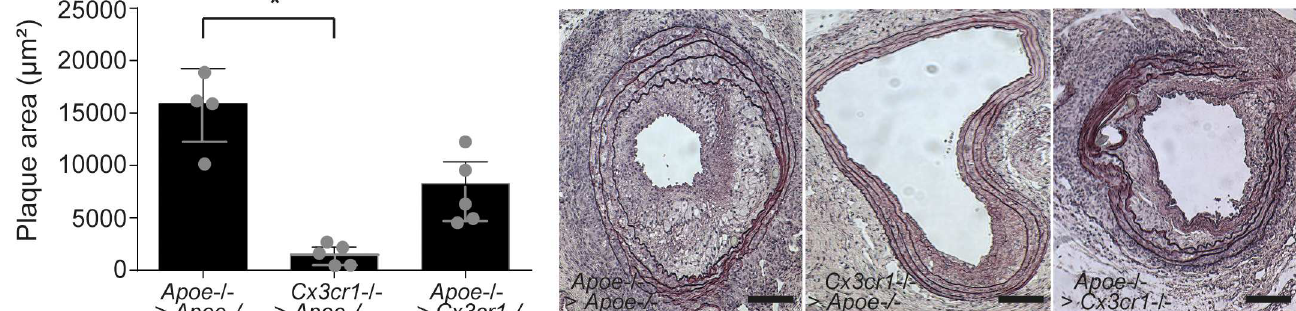
Fig 1. Reduced plaque size after transplantation of Cx3cr1 -/- Apoe -/- aortas into Apoe -/- mice. Apoe -/- mice were transplanted with Apoe -/- aortic segments(n = 4, Apoe -/- > Apoe -/- ) or Cx3cr 1 -/- Apoe -/- aortic segments (n = 5, Cx3cr 1 -/- > Apoe -/- ), and Cx3cr 1 -/- Apoe -/- mice were transplanted with Apoe -/- aortic segments (n = 5, Apoe -/- > Cx3cr 1 -/- ) and placedon a high fat diet for 4 weeks. Atherosclerotic plaqueswere analysedin H&E stained sectionsthrough the transplanted segment. Quantification of plaquearea and representative sections (x20) are shown. * p < 0.05,Scale bars 100 μ